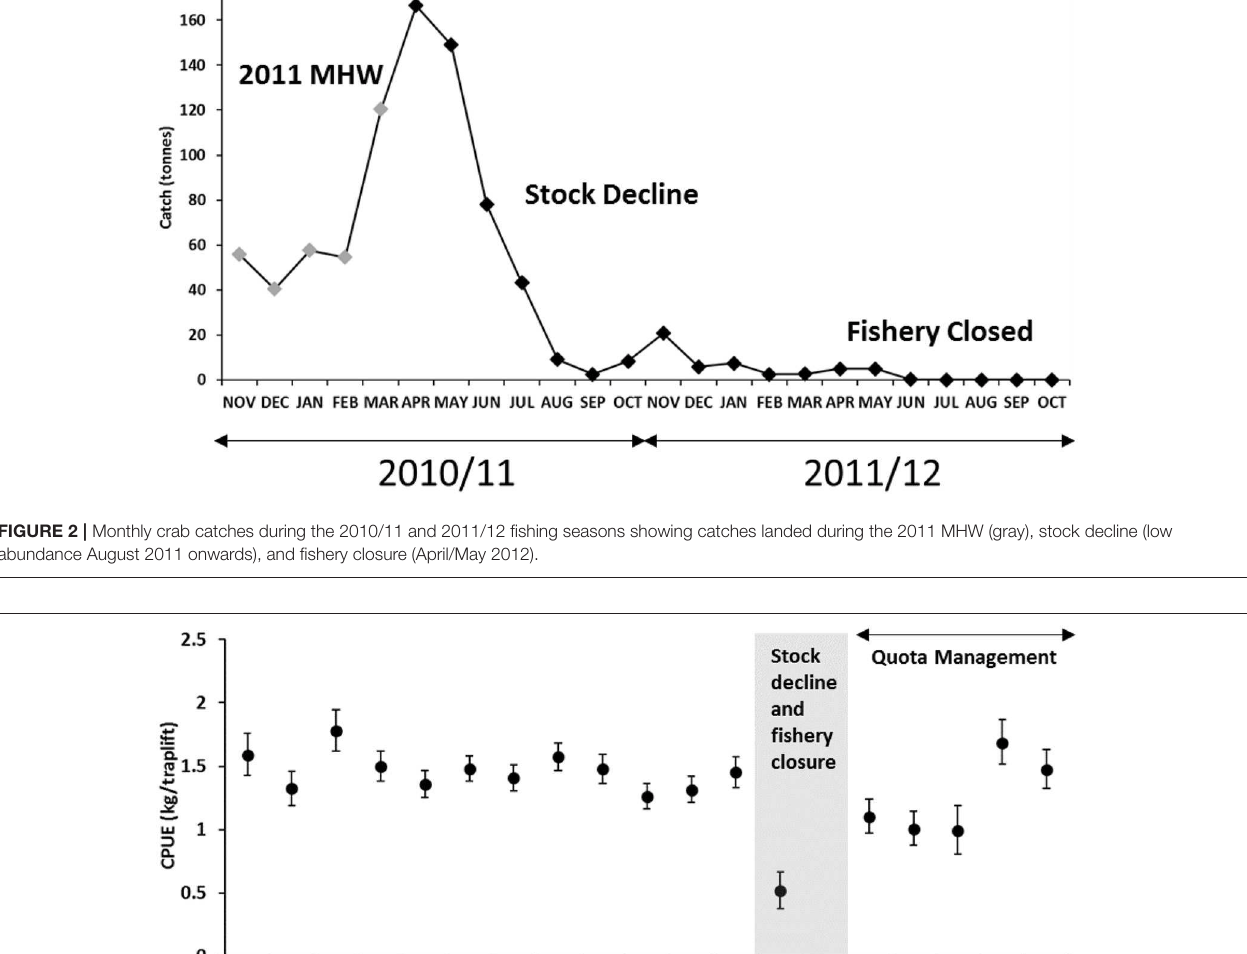
Frontiers in Marine Science |